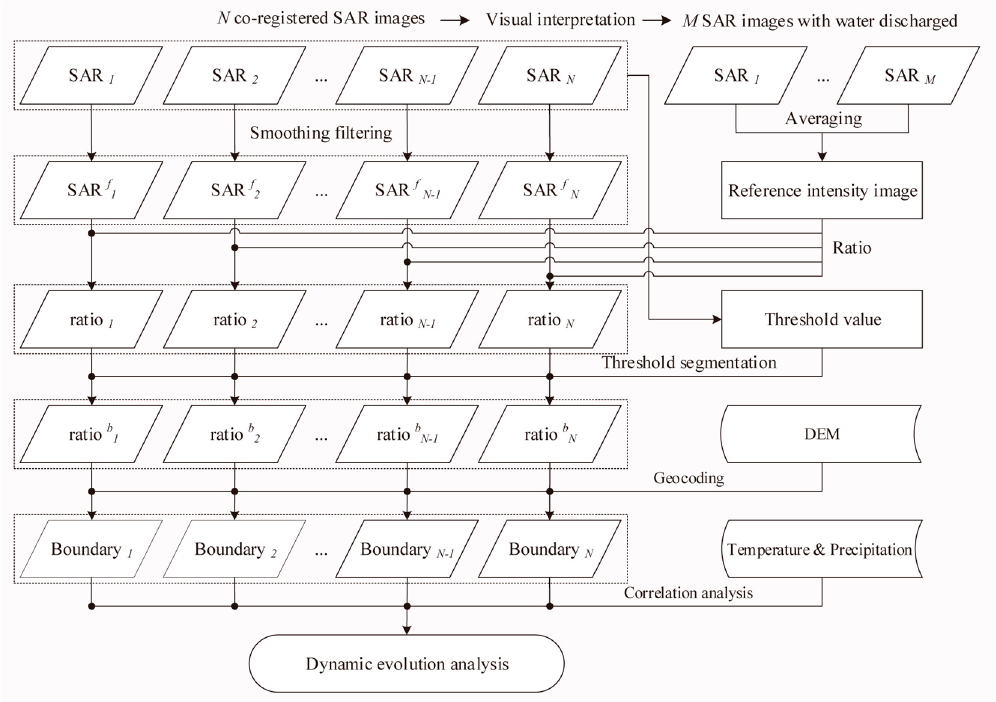
Figure 2. The flow chart of data processing for identifying the boundaries of glacial lakes based on proposed method. SAR f and ratio f denote the smoothed filtered synthetic aperture radar (SAR) image and the binarized classified ratio N N map, respectively.